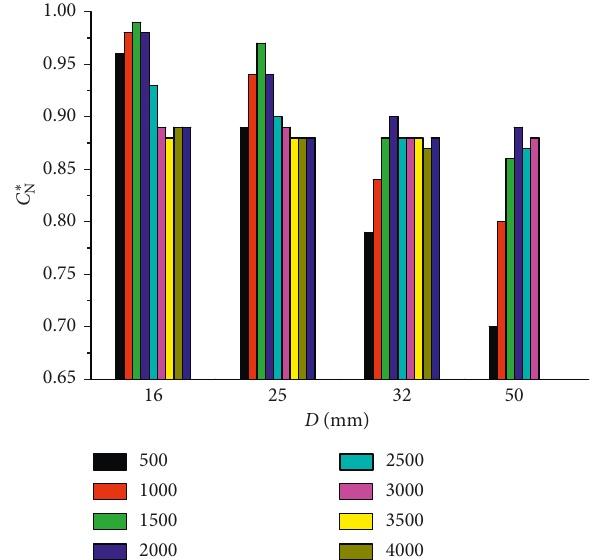
Figure 6: Normalized north outlet concentration C ∗ diameters D under Re ave � 500 ∼ 5000 at cross junction.